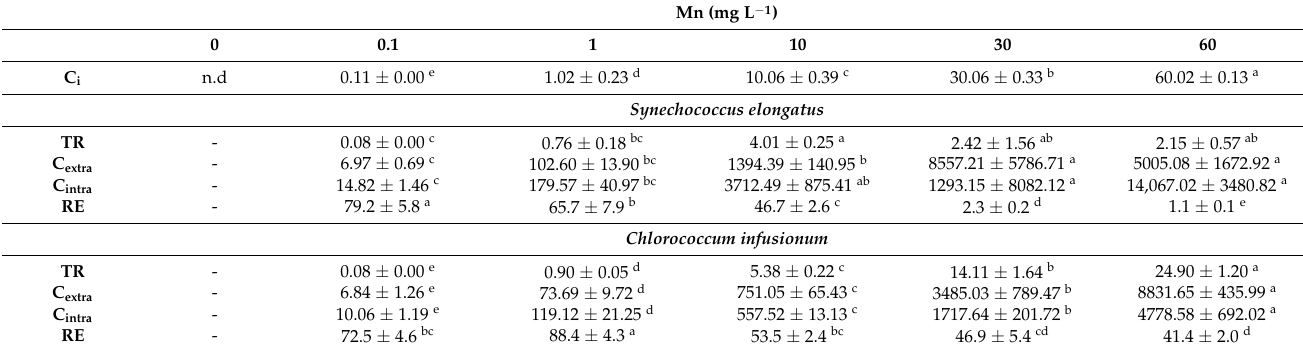
Table 2. Initial concentration in the media (C i , mg L − 1 ), total removal (TR, mg L − 1 ), extracellular concentration (C extra , ng 10 − 6 cells), intracellular concentration (C intra , ng 10 − 6 cells), and metal-removal efficiency (RE, %) in Synechococcus elongatus and Chlorococcum infusionum cells exposed to increased concentrations of Mn (mg L − 1 ) for 96 h. Data represent means of three replicates. Means ± SD of three replicates. Means followed by the same letter, in the line and within each metal and species, did not differ significantly ( p > 0.05) by the post hoc Tukey test. nd—not detected. Mn (mg L − 1 )